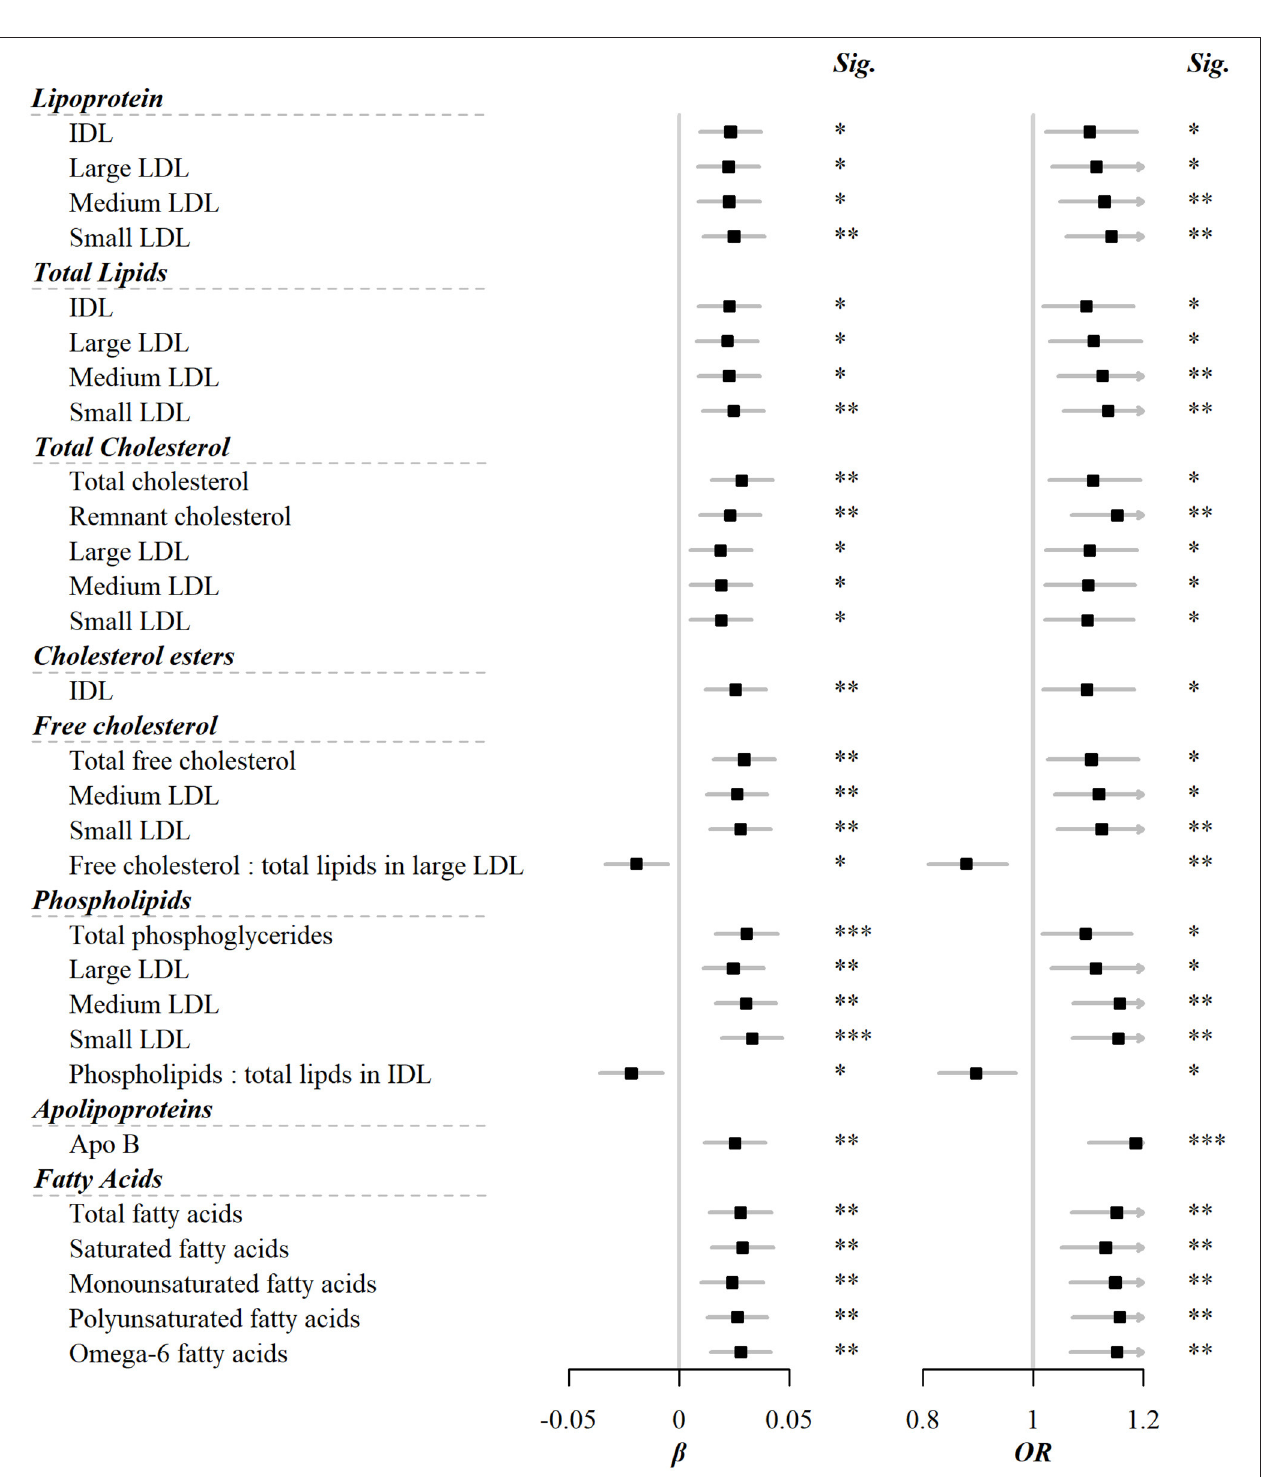
FIGURE 1 | Metabolic markers that significantly associated with both red meat consumption and risks of CVD. Models were adjusted for age, sex, region, education, household income, occupation, marital status, tea-drinking habit, smoking status, alcohol intake, physical activity, self-rated health, fasting time, and frequency of other 11 food groups. Black squares represented coefficients or ORs, while gray horizontal lines represented 95%CI. Significance (Sig.): * p < 0.05, ** p < 0.01, *** p < 0.001 (FDR-adjusted p using the Benjamini-Hochberg method).